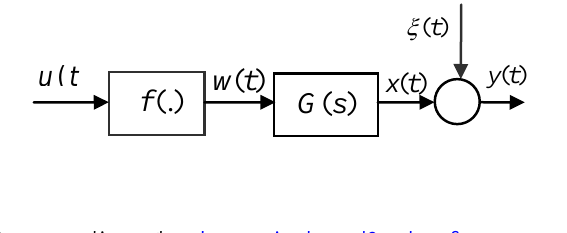
Fig. 1. Nonparametric Hammerstein